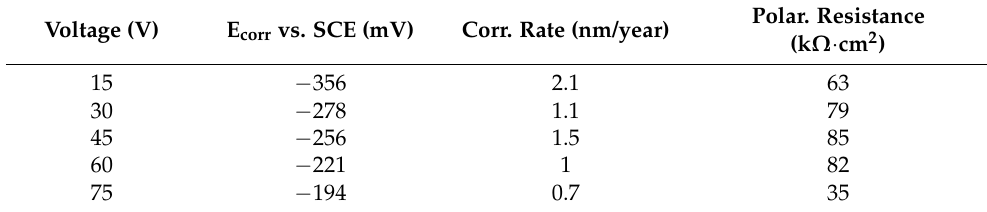
Table 4. Table 4. Corrosion parameters of anodically colored surfaces. Voltage Table 5. Cell viability after a contact and extract test was performed on the anodic colored sur- faces .